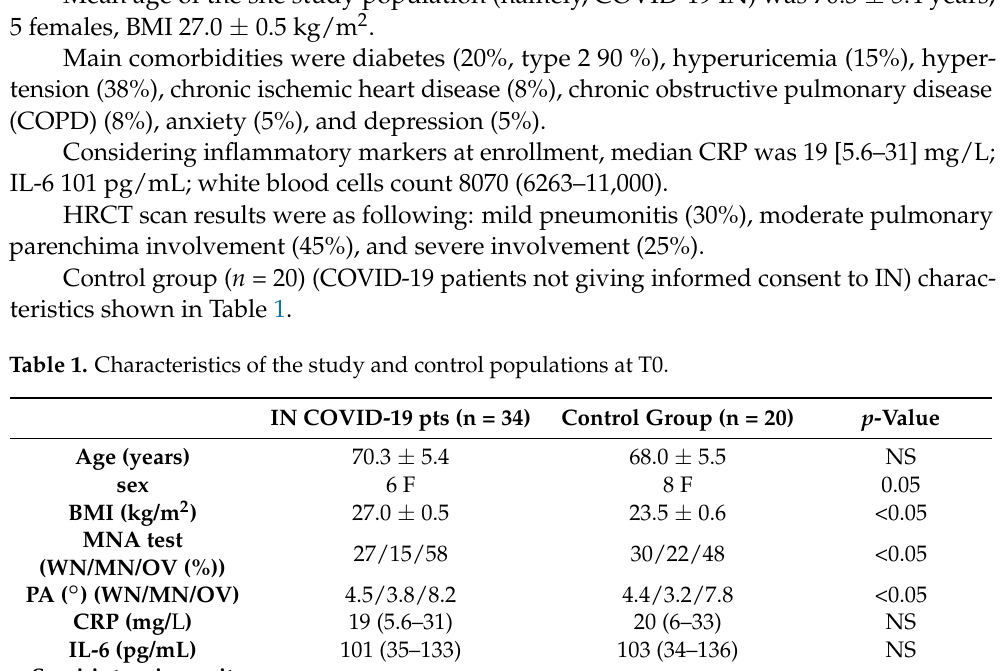
Table legend: NS: non-significant; F: female sex; MNA: mini nutritional assessment test; WN: well-nourished; MN: malnourished; OV: over-weight; PA: phase angle obtained through bioimpedance vector analysis (BIVA) measurement; CRP: C reactive protein; IL-6: interleukine